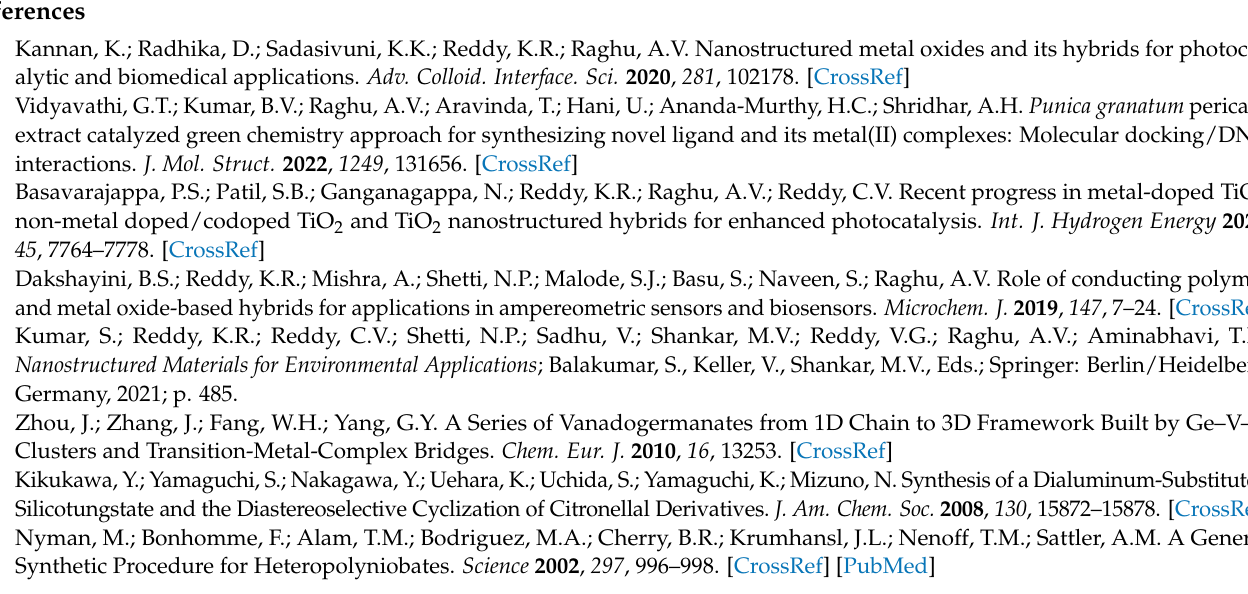
Figure S2: Simulated and experimental XRD patterns of compounds 1 – 4 ; Figure S3: UV-Vis spectra of compounds 1 – 4 ; Figure S4: EPR spectra of compounds 1 – 4 ; Figure S5: Simulated, experimental XRD patterns and XRD patterns after three cycles of compounds 3 ; Figure S6: FT-IR spectrum of compound 3 and FT-IR spectra of compound 3 after three cycles; Table S1: Bond valence sum calcu- lations for Ge, V and O in compounds 1 – 3 ; Table S2: Comparison of the catalytic performances of our compounds and other reported POMs [83,84]. References [85,86] are mentioned in Supplemen- tary